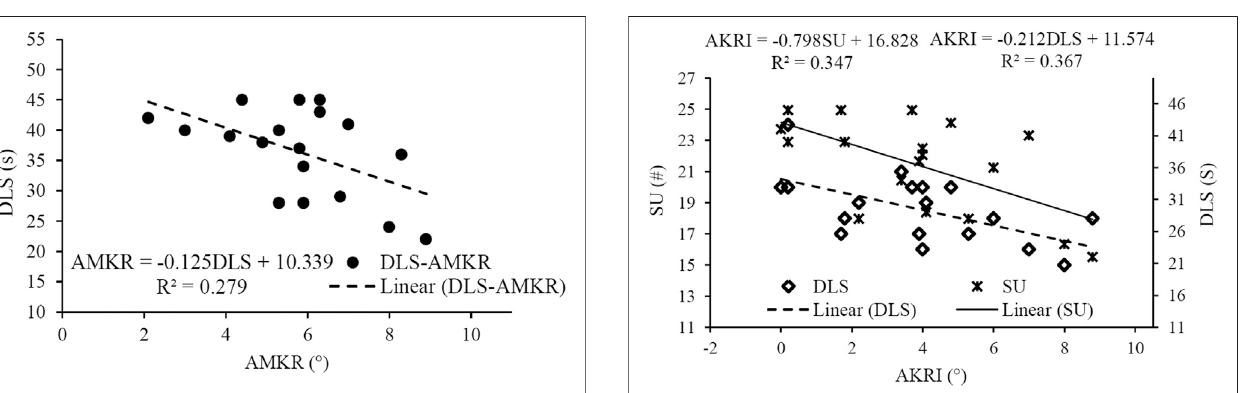
FIGURE 6 | Results of linear regression analyses of the knee internal rotationangleatinitialcontact(AKRI)withthe fi vecore-relatedmeasurements, which included dominant extremity single-leg hop distance normalized by body height (DLH/H), sit-ups in 20 s (SU), dominant extremity single-leg stancetime(DLS),trunk fl exionandextensionrangeofmotion(TFE),andtrunk extensor endurance